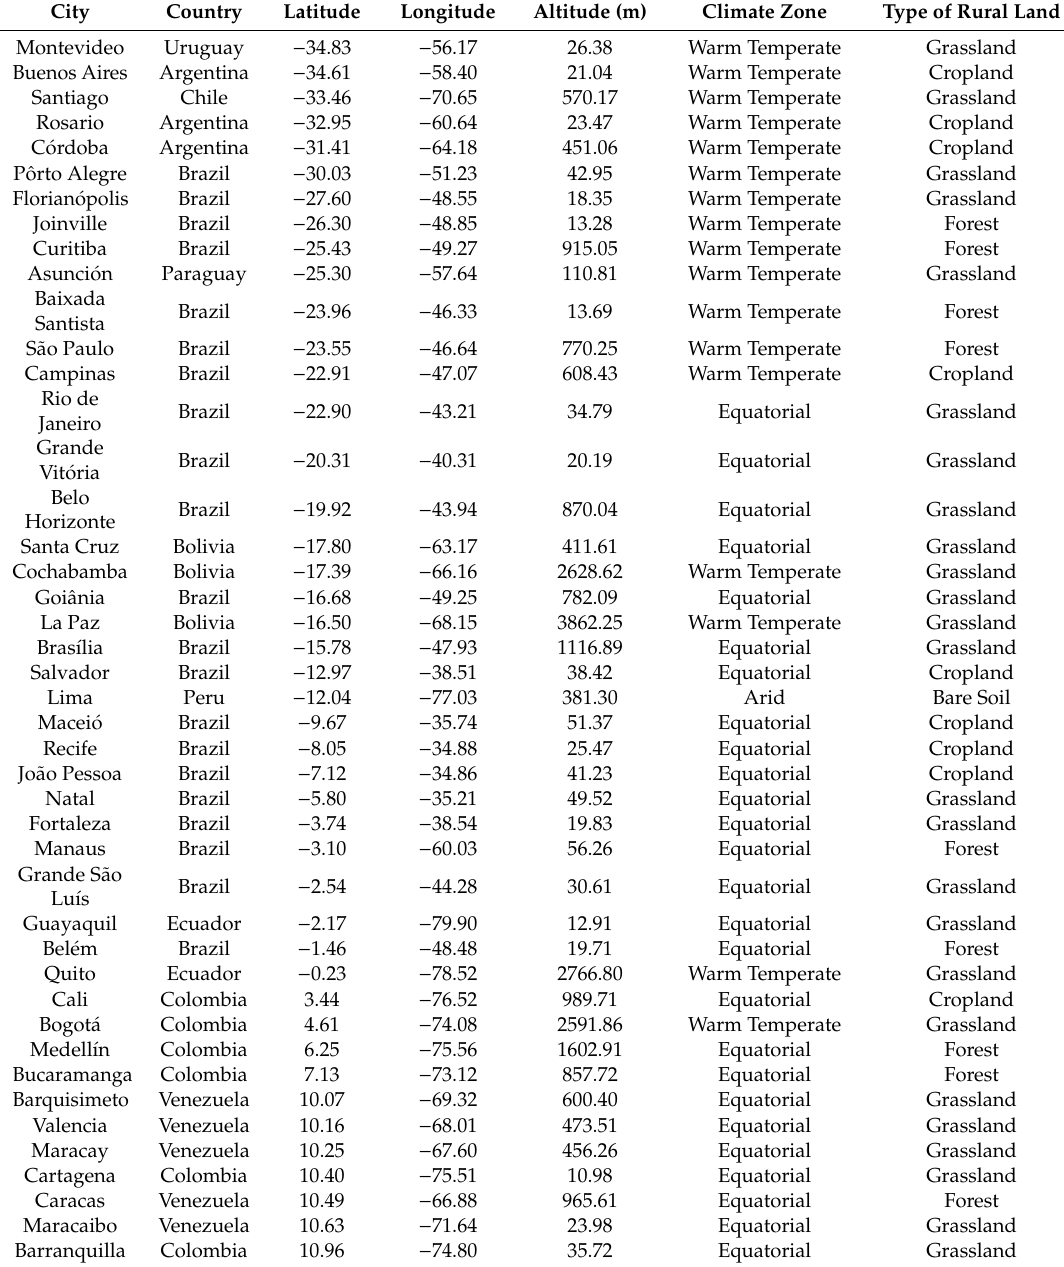
Table 1. The local information of each city, including the country, latitude, longitude, altitude, climate zone, and type of rural land. The climate zone divisions are based on the Köppen–Geiger